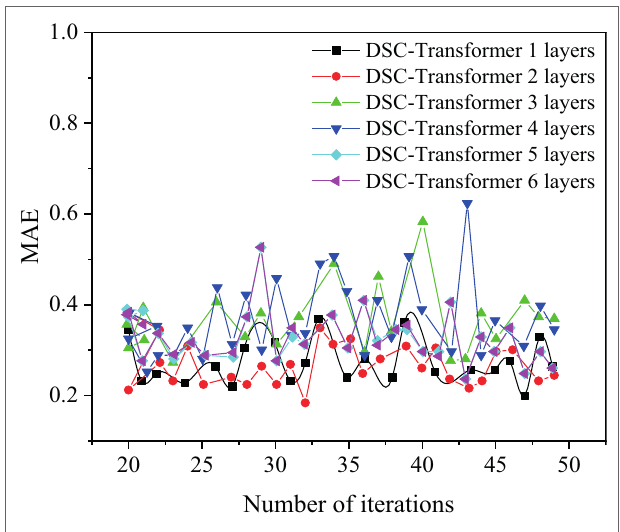
FIGURE 8 | The corresponding MSE and MAE values when the learning rate is 1e-3.